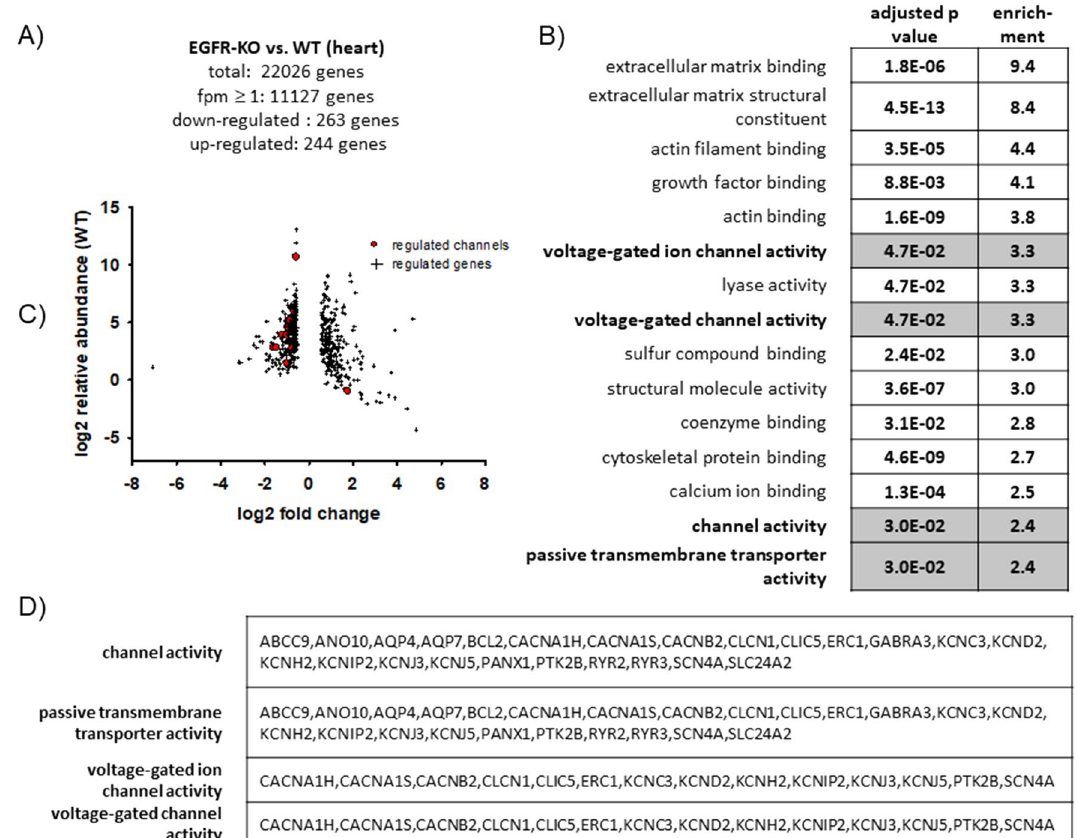
Figure 2. Influence of EGFR on the gene expression in heart tissue. ( A ) Next generation sequencing (NGS) experiments of heart tissue RNA of EGFR-KO and WT mice performed at the IZKF Leipzig Core Facility (Dr. Krohn) (N = 6). Of 22,026 genes, 11,127 were detectable with a mean fpm value of at least 1. 507 genes were regulated at least 1.5 fold and possessed a cohen´s d of ≥ 2 or ≤ 2 and were therefore considered relevantly regulated. Of those genes 263 genes were down-regulated and 244 were upregulated. ( B ) Functional enrichment analyses performed with the 507 relevantly regulated genes of our NGS analysis with G-profiler (https:// biit. cs. ut. ee/ gprofi ler/ gost): GO terms for molecular function with an adjusted p value of ≤ 0.05, at least twofold enrichment and an intersection size > 10 are listed with their respective adjusted p values and enrichment. Terms associated with transporter and channel activity are printed in bold. ( C ) Comparison of log2 relative abundance (WT) of wild type and log2 fold change (KO compared to WT) of all relevantly regulated genes of the NGS data with ion channels marked as circles. ( D ) List of regulated genes for all transporter- and channel- associated GO EGFR-dependent changes were selected and validated in hearts of EGFR KO and WT animals with qPCR using specific primers (Fig. 3B). CACNA1H was not included in our predesigned qPCR arrays but was added in our